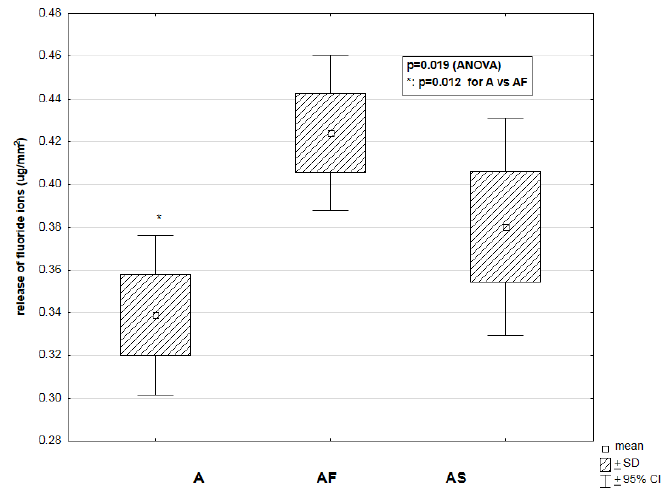
Figure 4. Relationship between the type of ormocer material (A—Admira ( n = 5); AF—Admira Flow ( n = 5); AS—Admira Seal ( n = 5)) and the release of fluoride ions ( μ g/mm²) into the saline solution in a period of 2352 h.